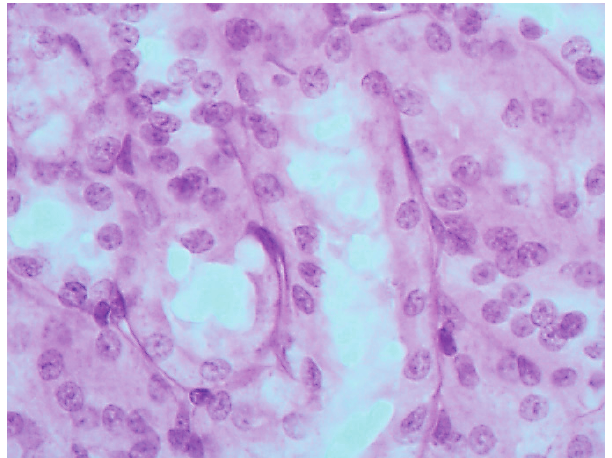
Figure 3. Kidney of a rat exposed to nanoparticles of NiO and Mn 3 O 4 together. Marked degenerative and necrobiotic changes of tubular epithelial cells up to their disappearance; partial destruction of the brush border. PAS stain, magnification